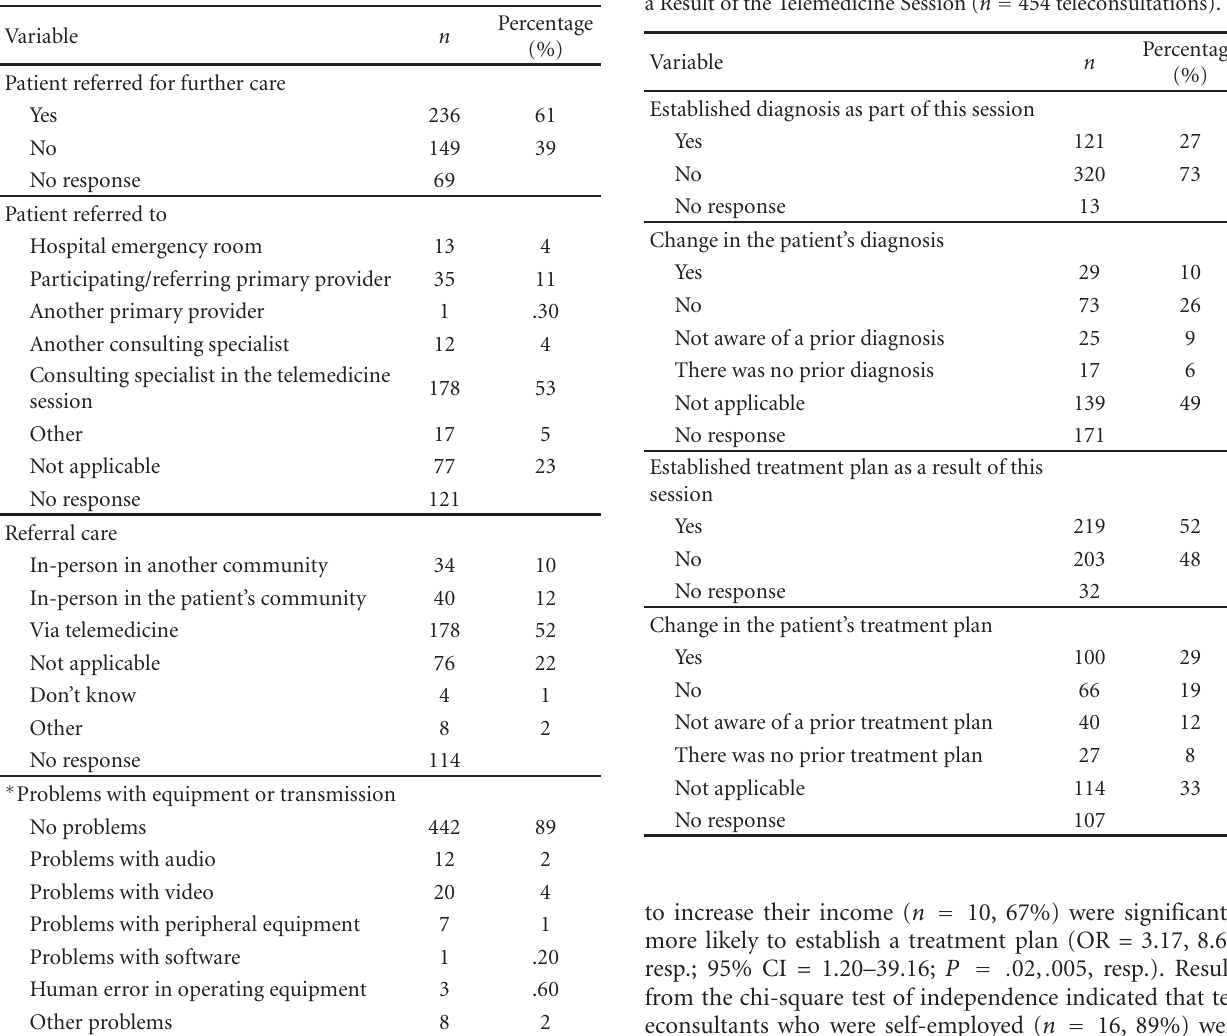
Table 3: Characteristics of the Teleconsultations ( n = 454). Table 4: Changes in the Patient’s Diagnosis and Treatment Plan